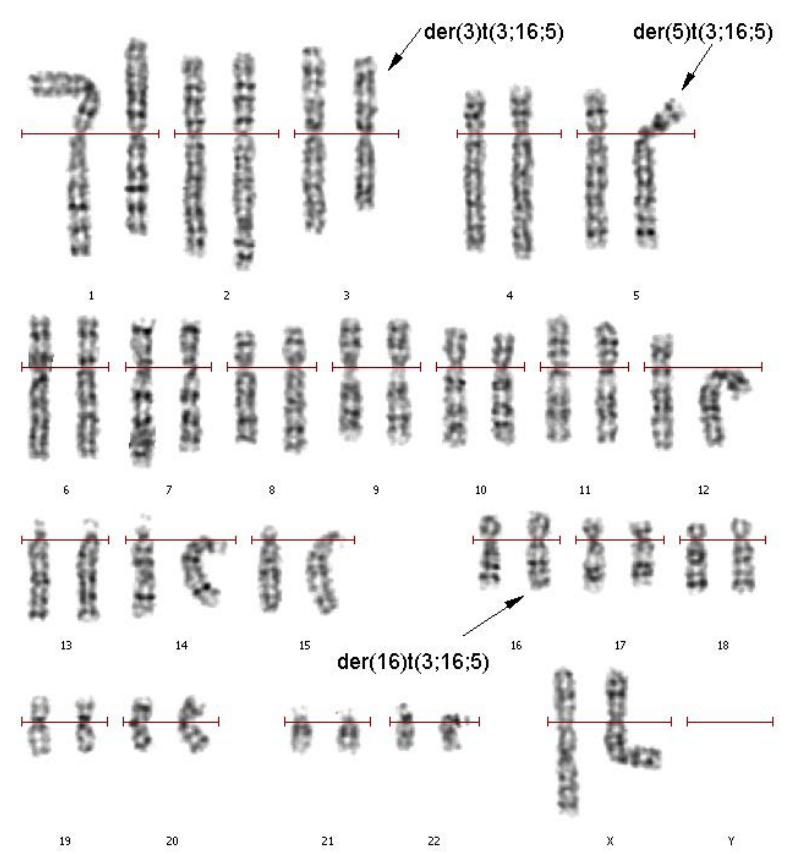
Figure 1. GTG (G-bands after trypsin and Giemsa) di ff erentially stained chromosomes of a patient with a complex chromosomal rearrangement (CCR). der(3)t(3;16;5), der(5)t(3;16;5), der(16)t(3;16;5) reflect derivatives of chromosomes 3, 5, and 16 involved in the